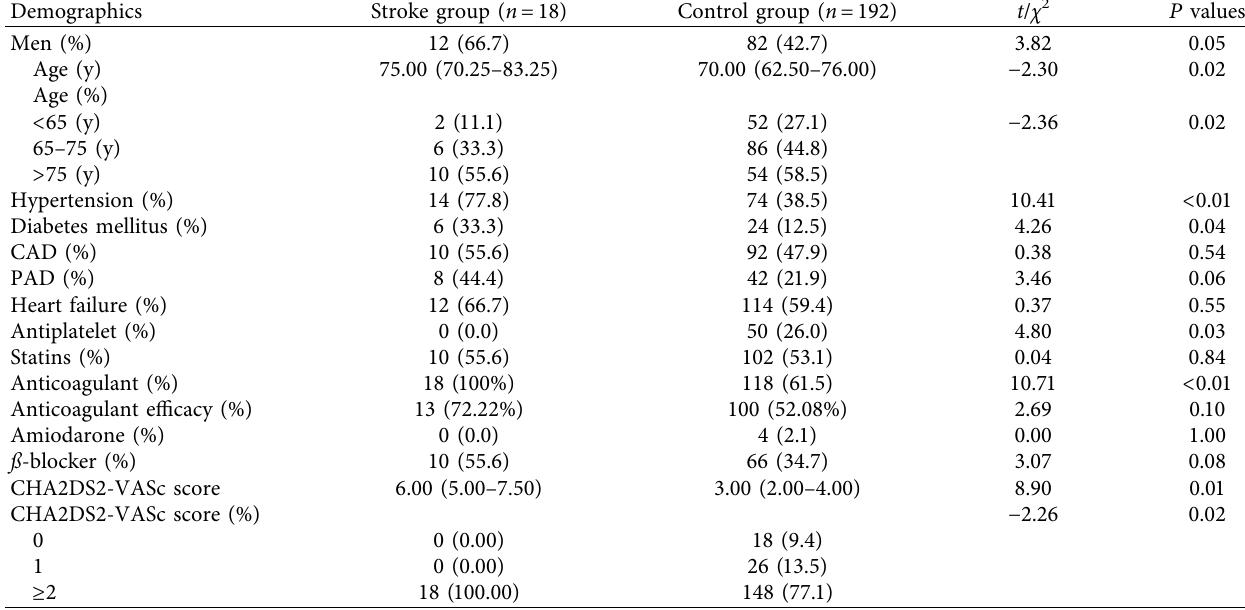
Table 1: Baseline characteristics of